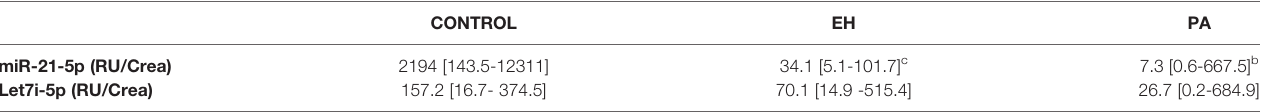
TABLE 5 | Expression of miR-21-5p and Let-7i-5p in urinary extracellular